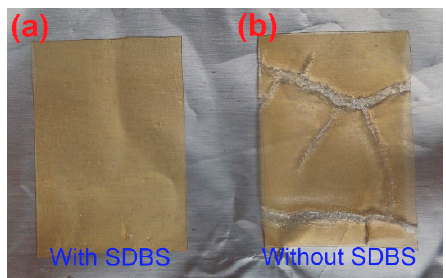
Figure 2. Comparison of the SPI/SDBS/PEGE4% ( a ) and SPI/PEGE4% films ( b ).